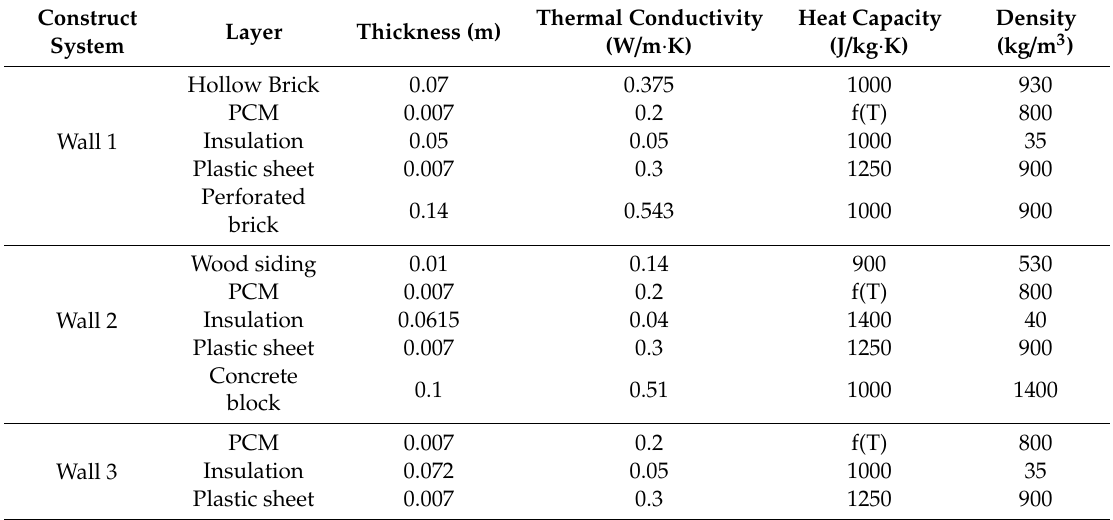
Table 1. Thermo-physical properties and constructive systems description (listed from outside to